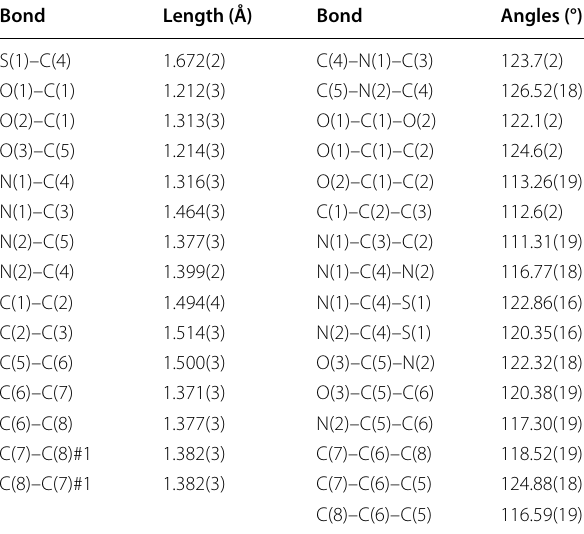
Table 2 Selected bond lengths (Å) and bond angles (°) for isomer 1B